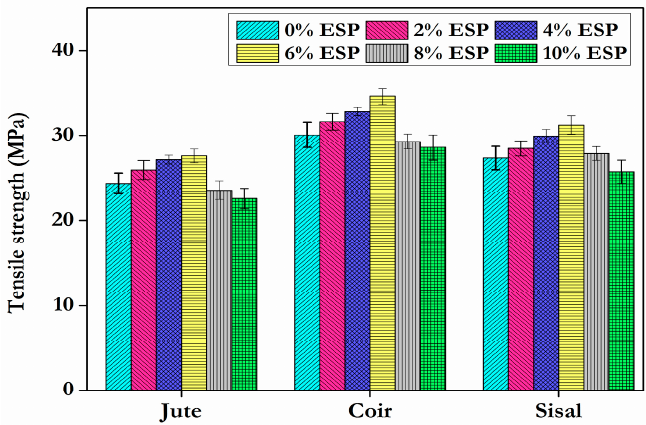
Figure 5. Tensile strengthof composite specimens with different fibres.